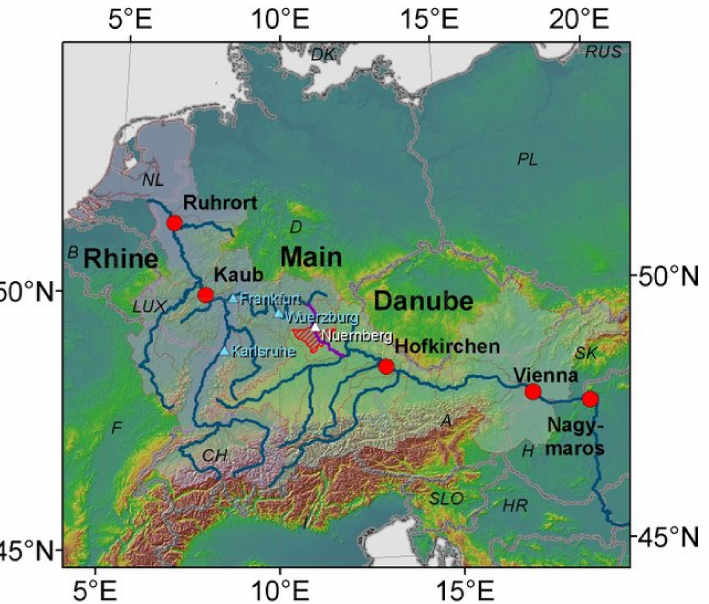
Figure 4. The Rhine–Main–Danube transport corridor, showing the Main–Danube Canal. Legend: the Main–Danube canal